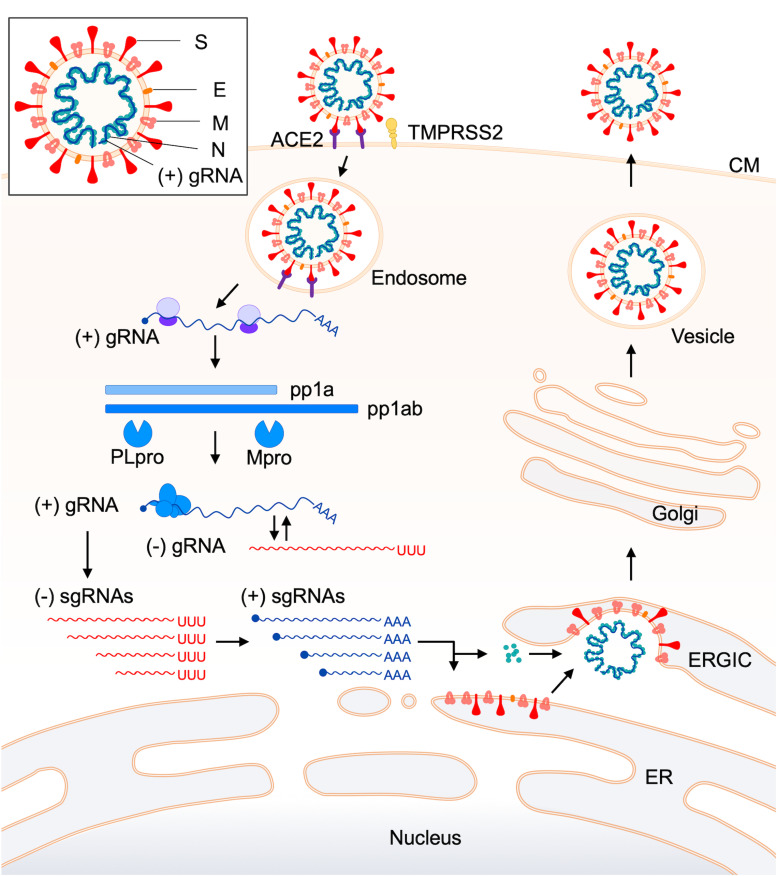
Replication cycle of coronaviruses. The replication process of coronaviruses is schematically shown from the virus attachment to target cells up to the virus release from infected cells (de Haan and Rottier, 2005; Fehr and Perlman, 2015; de Wilde et al., 2018; Oberfeld et al., 2020; Tse et al., 2020). An entry receptor and a co-factor for efficient viral entry (ACE2 and TMPRSS2, respectively, in this case) are indicated. For details of the replication steps, see the text. A schema of the coronavirus virion is also shown in a box at the top-left. Abbreviations (Fehr and Perlman, 2015; de Wilde et al., 2018): ACE2, angiotensin-converting enzyme 2; TMPRSS2, transmembrane protease, serine 2; CM, cell membrane; gRNA, genomic RNA; pp, polyprotein; PLpro, papain-like protease; Mpro, main protease; sgRNA, subgenomic RNA; ERGIC, endoplasmic reticulum-Golgi intermediate compartment; ER, endoplasmic reticulum.